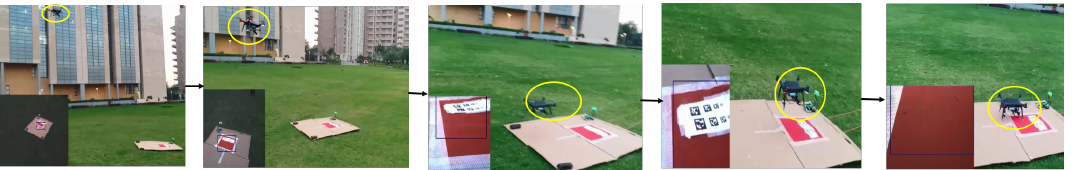
Figure 13. Straight line moving target trial 2: ( a ) vehicle’s trajectory; ( b ) longitudinal velocity profile for landing on a straight-line moving target for a different set of log polynomial parameters ( a , b , c ) = ( 55,115, − 161 ) .